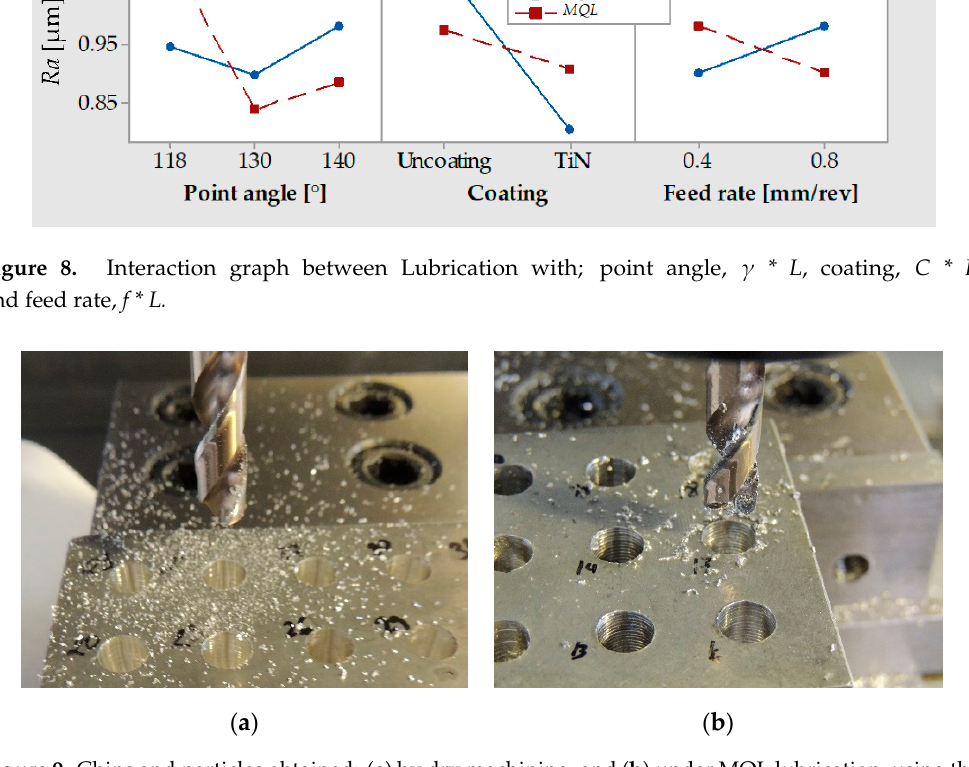
Figure 9. Chips and particles obtained: ( a ) by dry machining, and ( b ) under MQL lubrication, using the same operating parameters. Figure 8. Interaction graph between Lubrication with; point angle, γ * L , coating, C * L , and feed rate, f * L.